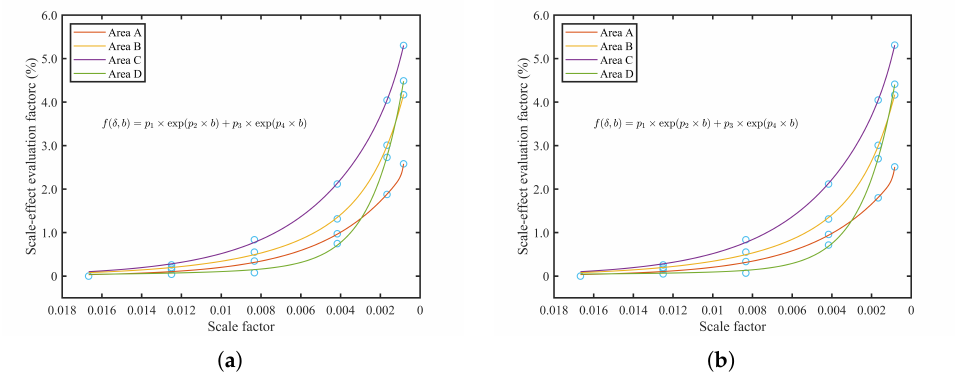
Figure 10. Scale-effect evaluation factor of multiscale DEMs of four lunar regions based on the MRRT model under different illumination geometry: ( a ) (0 ◦ , 150 ◦ ) and ( b ) (45 ◦ , 150 ◦ ). Six scale factors are 1/60, 1/80, 1/120, 1/240, 1/600, and 1/1200,